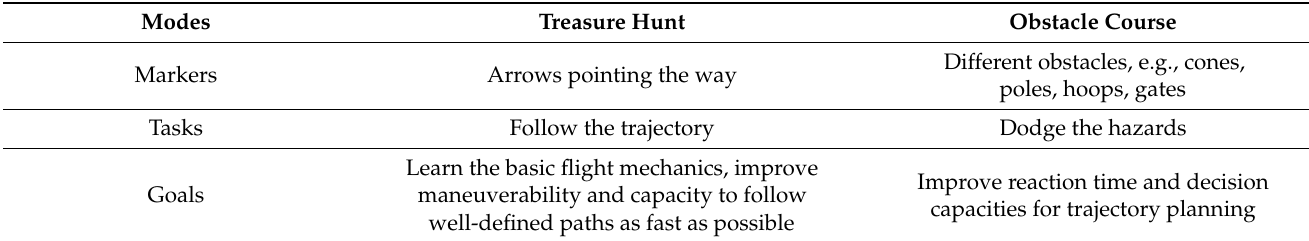
Table 2. Differences between the strategies depicted and included in the proposed solution, which are the treasure hunt and the obstacle course modes.